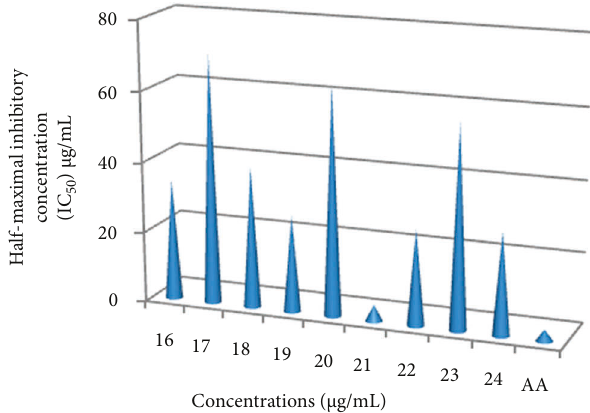
Figure 3: Half-maximal inhibitory concentration (IC thesized compounds (16–24) as compared to that of ascorbic acid.